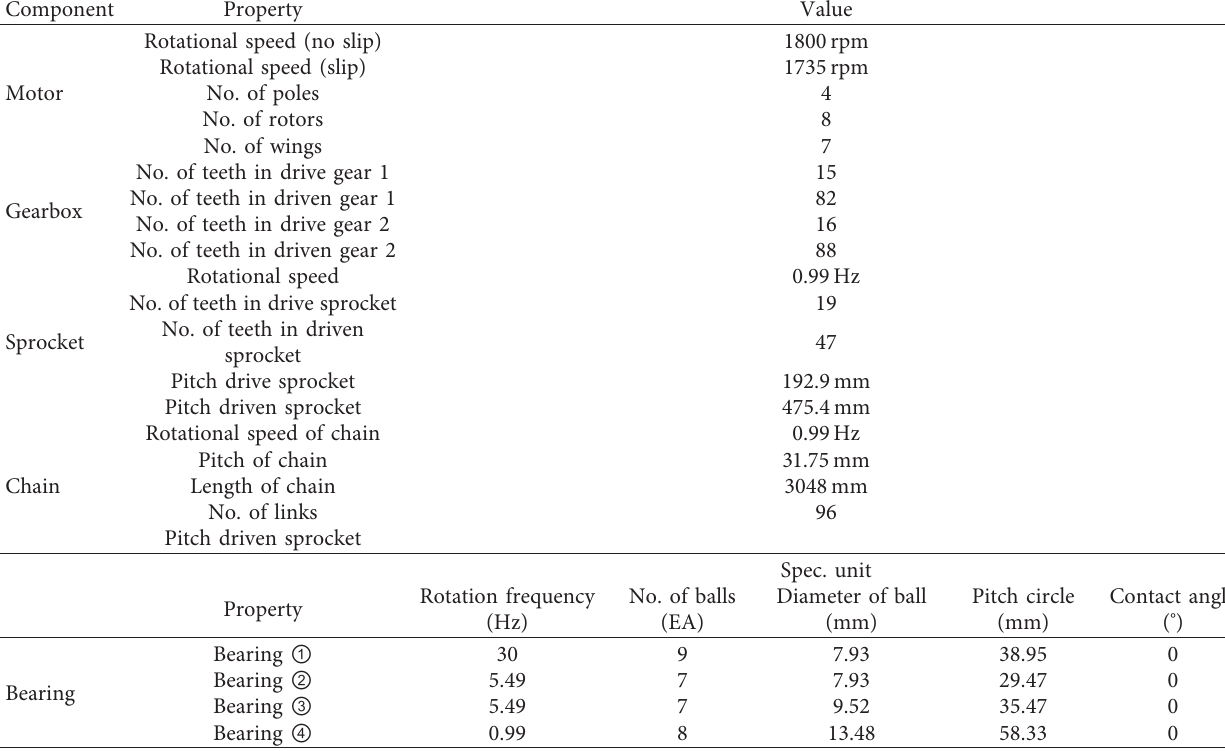
Table 1: Technical specifications of the CSD